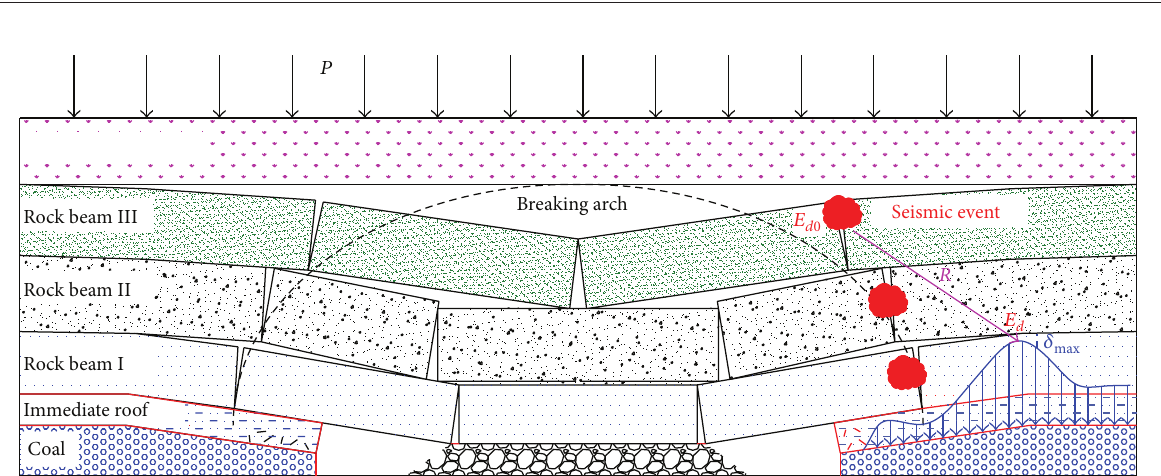
Figure 2: Mechanical structure of dynamic loading type during mining face